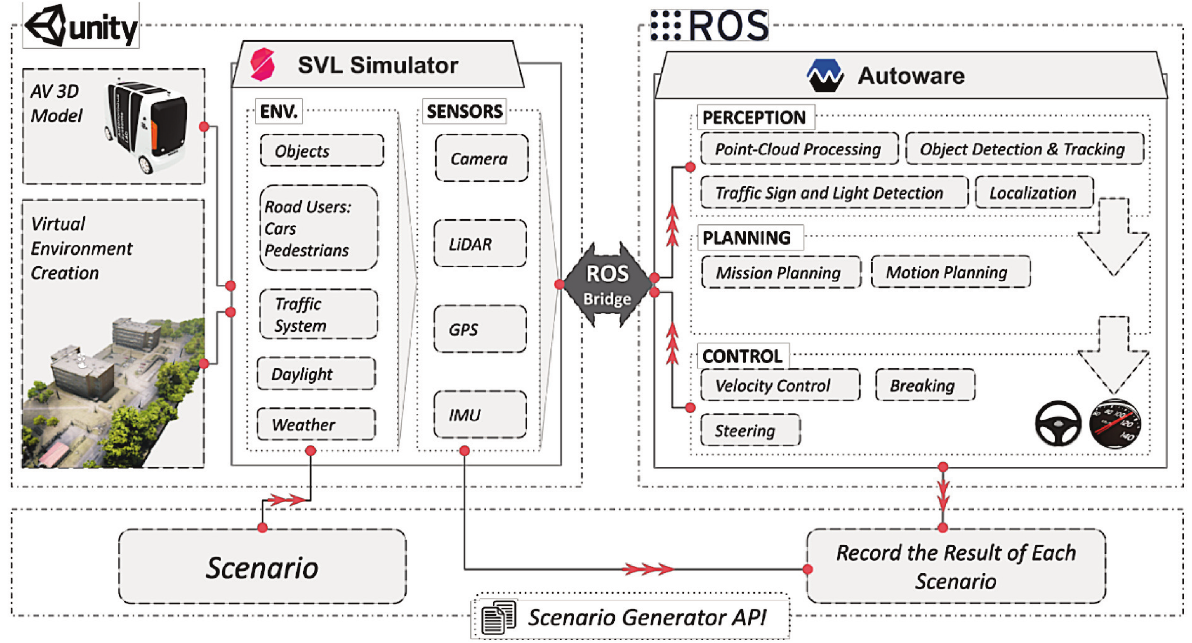
Fig. 2. High-level architecture of the simulation and the AV system.